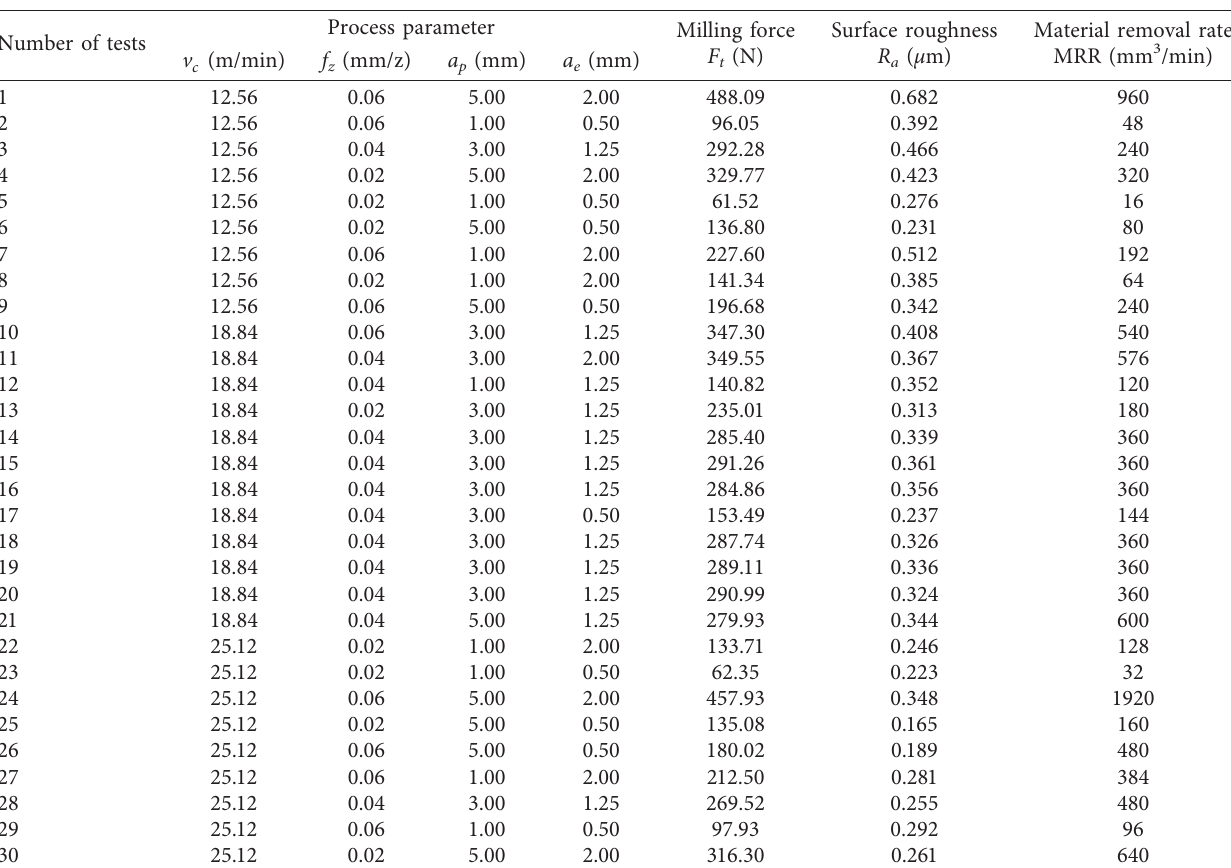
Table 4: Experimental scheme and results.